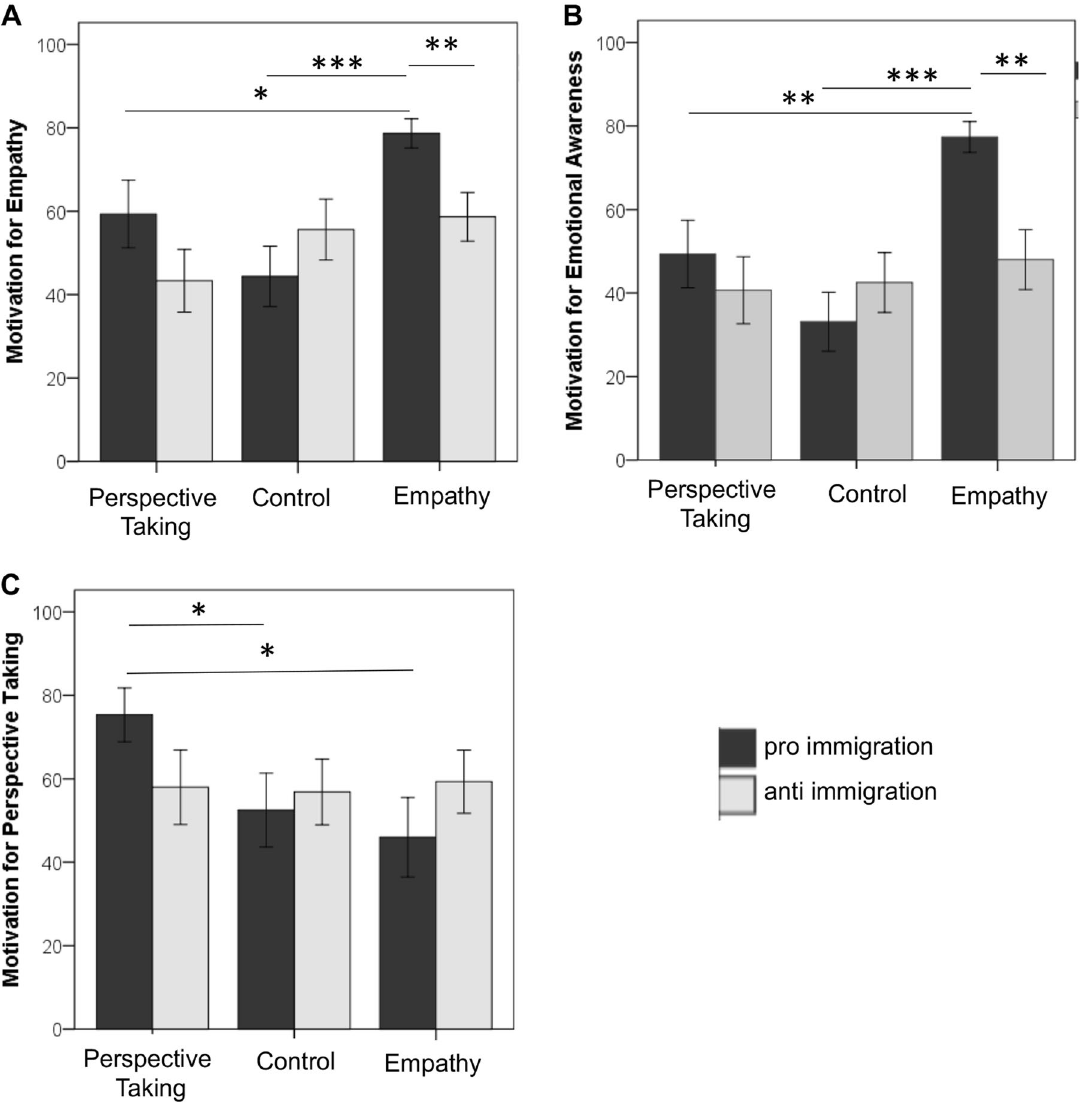
Fig. 1 Impact of the empathy or perspective taking instructions on the motivation to engage in empathy, emotional awareness, and perspective taking. Compared with pro-immigration participants in the control group, pro-immigration participants in the empathy group were a more motivated to feel empathy for the other and b more motivated to pay attention to their own emotions (emotional awareness). Similarly, pro-immigration participants were c more motivated to engage in perspective taking in the perspective-taking group than were pro-immigration participants in the control group. Furthermore, the motivation to engage in a empathy and b emotional awareness was higher in pro-immigration participants than in anti-immigration participants in the empathy group. Error bars depict ± 1 standard error. * p < 0.05, ** p < 0.01, *** p <